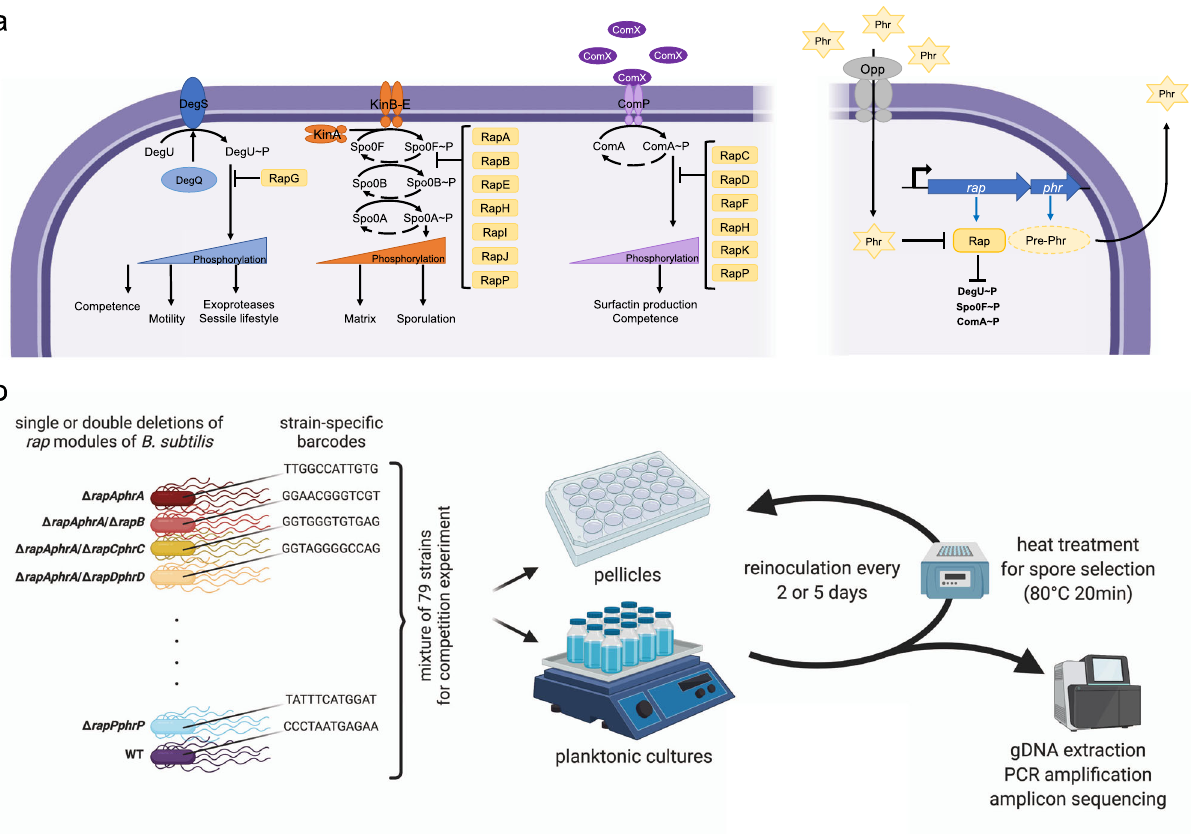
Fig. 1 Overview of Rap – Phr systems, Rap-in fl uenced global regulatory pathways, and the experimental setup. The left side of panel ( a ) depicts the three main regulatory pathways (DegS – DegU, Spo0A phosphorelay, and ComP – ComA from left to right, respectively) affected by Rap proteins. The right side of panel ( a ) indicates the Rap – Phr pathway, where processed and secreted Phr acts as a quorum sensing signal, which after uptake inhibits the function of the corresponding Rap proteins. T-ended lines depict inhibition, black arrows indicate activation, blue arrows symbolize transcription and translation. Panel ( b ) represents the main steps of the competition experiment performed in this study; created with